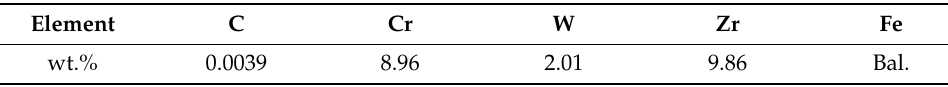
Table 1. Chemical compositions of Fe-Cr-Zr alloy. Element C Cr W Zr Fe wt.%